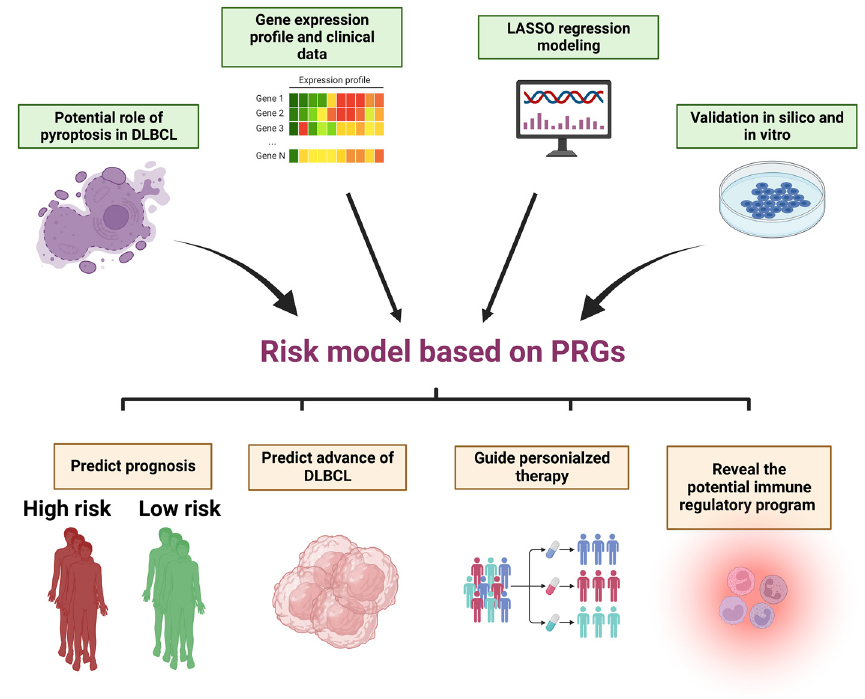
Figure 8. The workflow map. Created with BioRender.com (accessed on 31 October 2022). The publication license is available in Supplementary File S1.